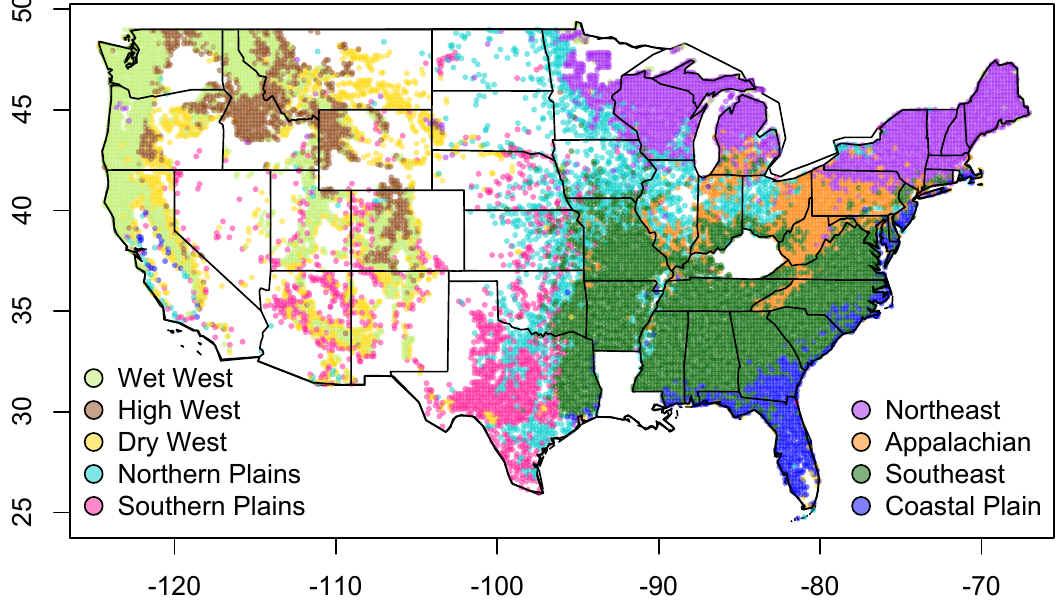
Figure 3. Map of tree assemblages included in this study, coloured by evolutionary group following a clustering analysis based on shared evolutionary history. Names for groups were chosen based on their geographic and/or climatic characteristics. Each assemblage consists of all FIA plots within a 0.2 ◦ by 0.2 ◦ grid